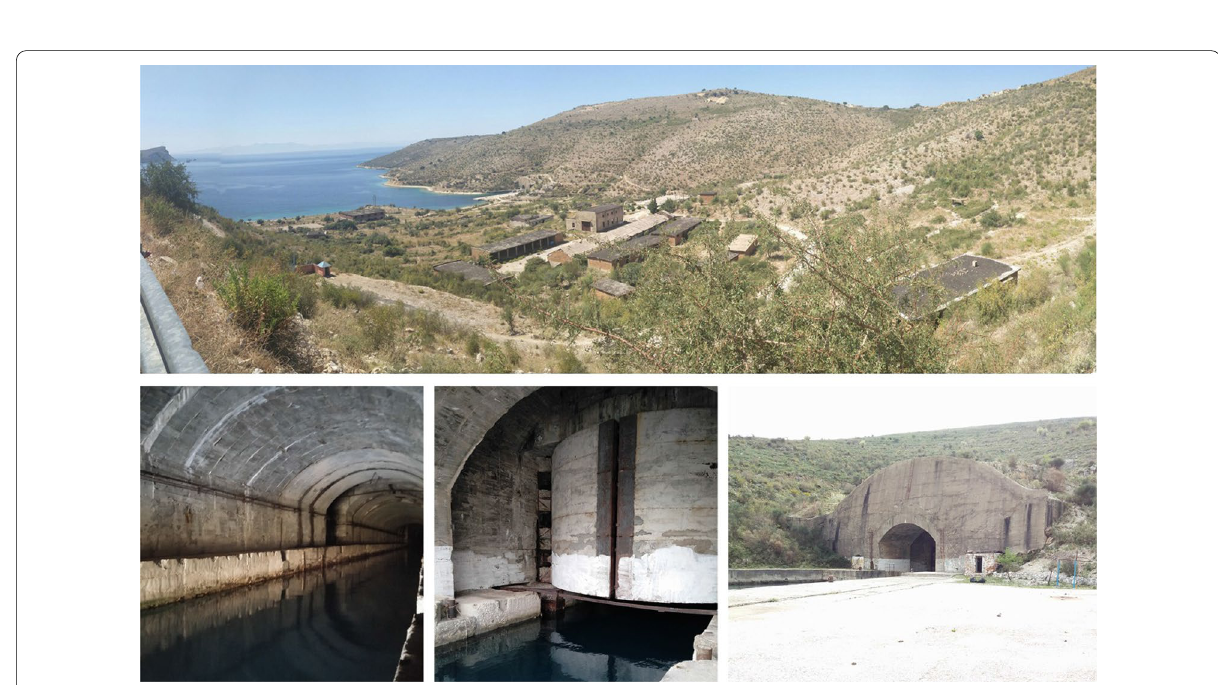
Fig. 15 Picture from the existing situation of Porto Palermo’s military base, Photo by Debora